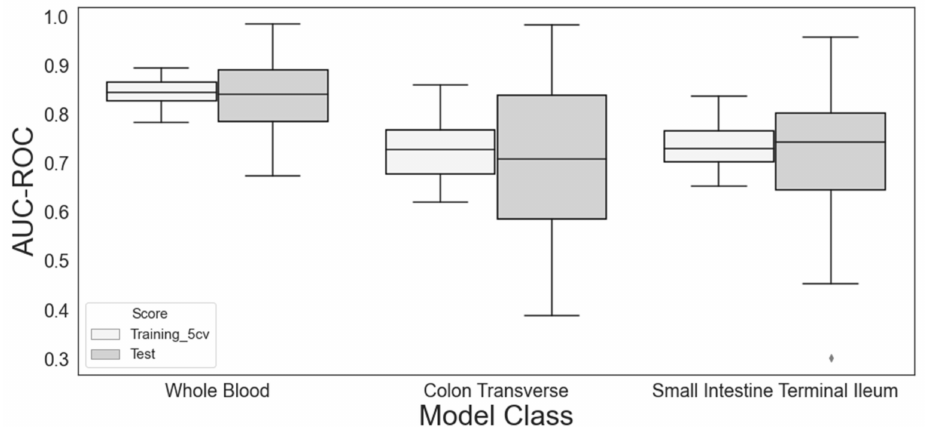
Figure 3. Performance of the three tissue models used for gene expression imputation in classifying the non-durable response (NDR) vs. the durable response (DR). The model training by 5-fold cross- validation and feature selection via LASSO and recursive feature elimination was repeated 100 times (see main text for details). The single most significant gene was selected from each trial. The training and test performances given as area under the receiver operating characteristic curve (AUC-ROC) are shown as boxplots. That from the whole-blood model was significantly higher than that from the colon transverse ( p t -test = 6.5 × 10 − 38 and 3.7 × 10 − 12 for the training and test sets, respectively) or the small intestine terminal ileum ( p t -test = 1.8 × 10 − 46 and 7.5 × 10 − 15 for the training and test sets, respectively).